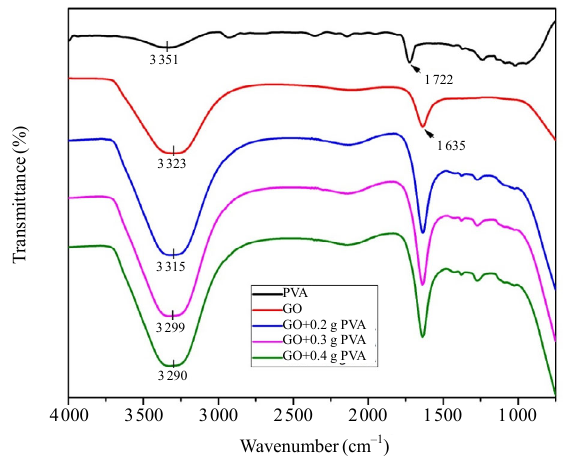
Fig. 4 FTIR curves of the PVA, GO, 10 ml GO + 0.2 g PVA, 10 ml GO + 0.3 g PVA, and 10 ml GO + 0.4 g